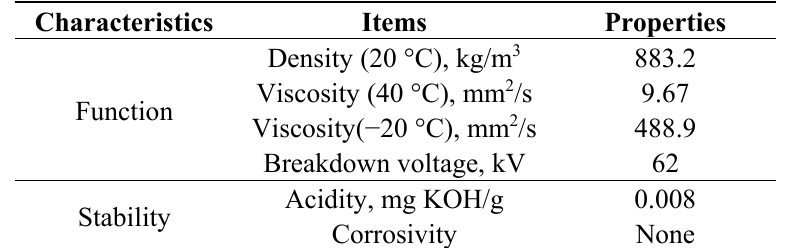
Table 1. Properties of tested mineral base insulation oil.